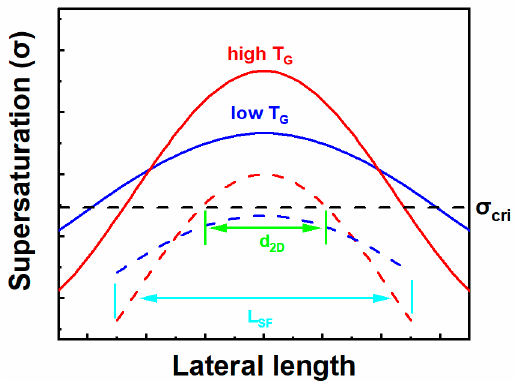
Figure 9. Surface supersaturation distribution on the step-free surface at different temperatures (red lines denote high growth temperature and blue lines denote low growth temperature) and different dimensions (solid lines represent large area and dashed lines represent small area). The x axis (lateral length) is along the m-direction at the center of the step-free surface.